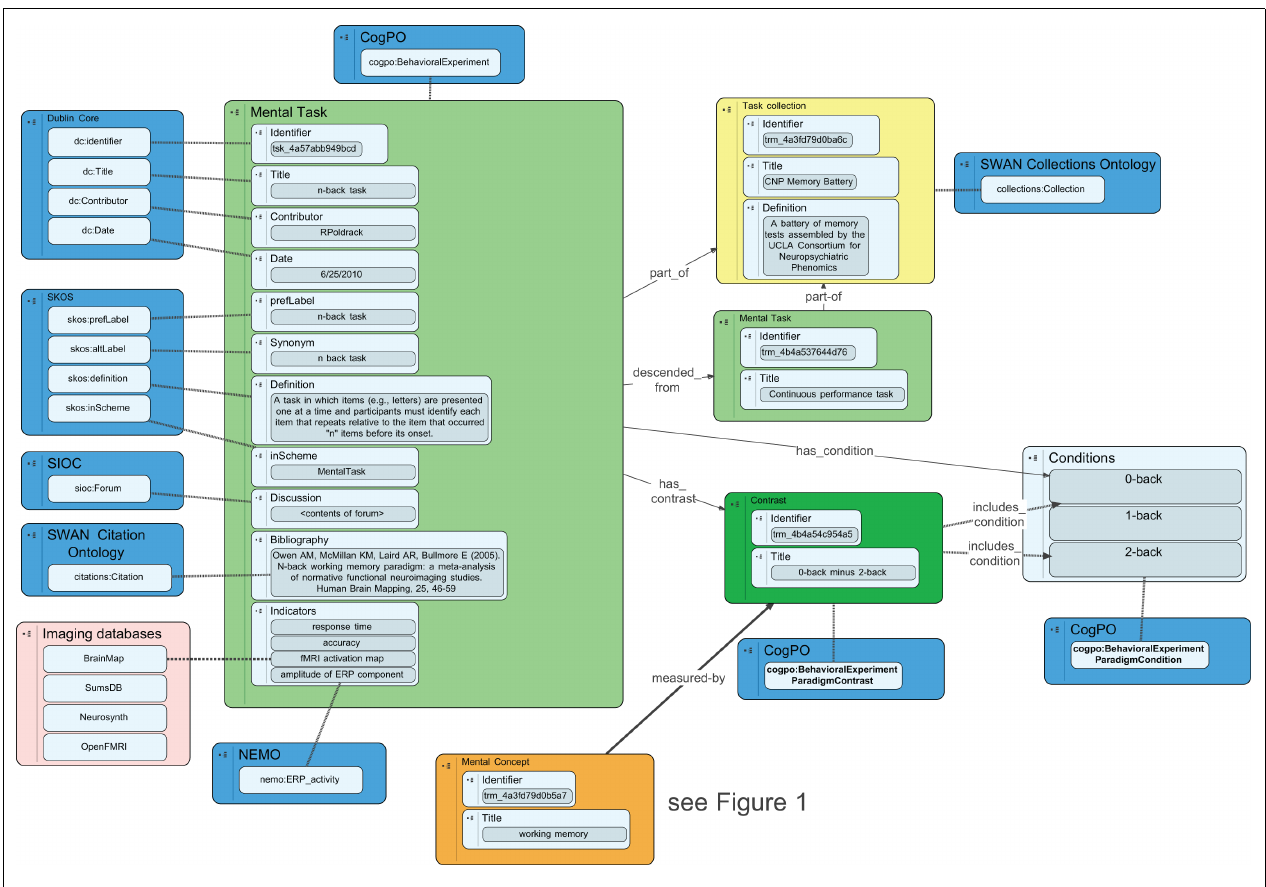
relations.The dashed line connecting activation maps to imaging databases is meant to reflect an empirical relation, as these databases do not currently expose formal